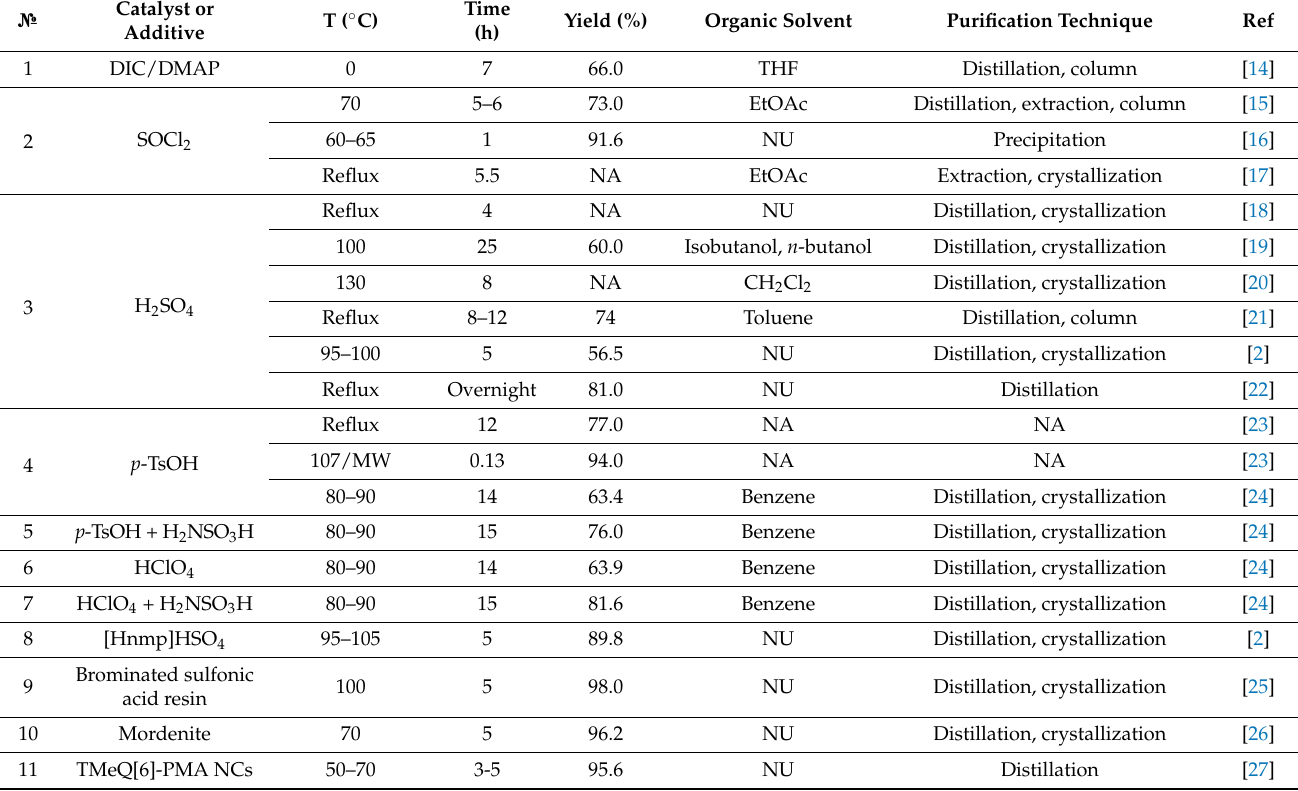
Table 1. The reported chemical methods for the preparation of